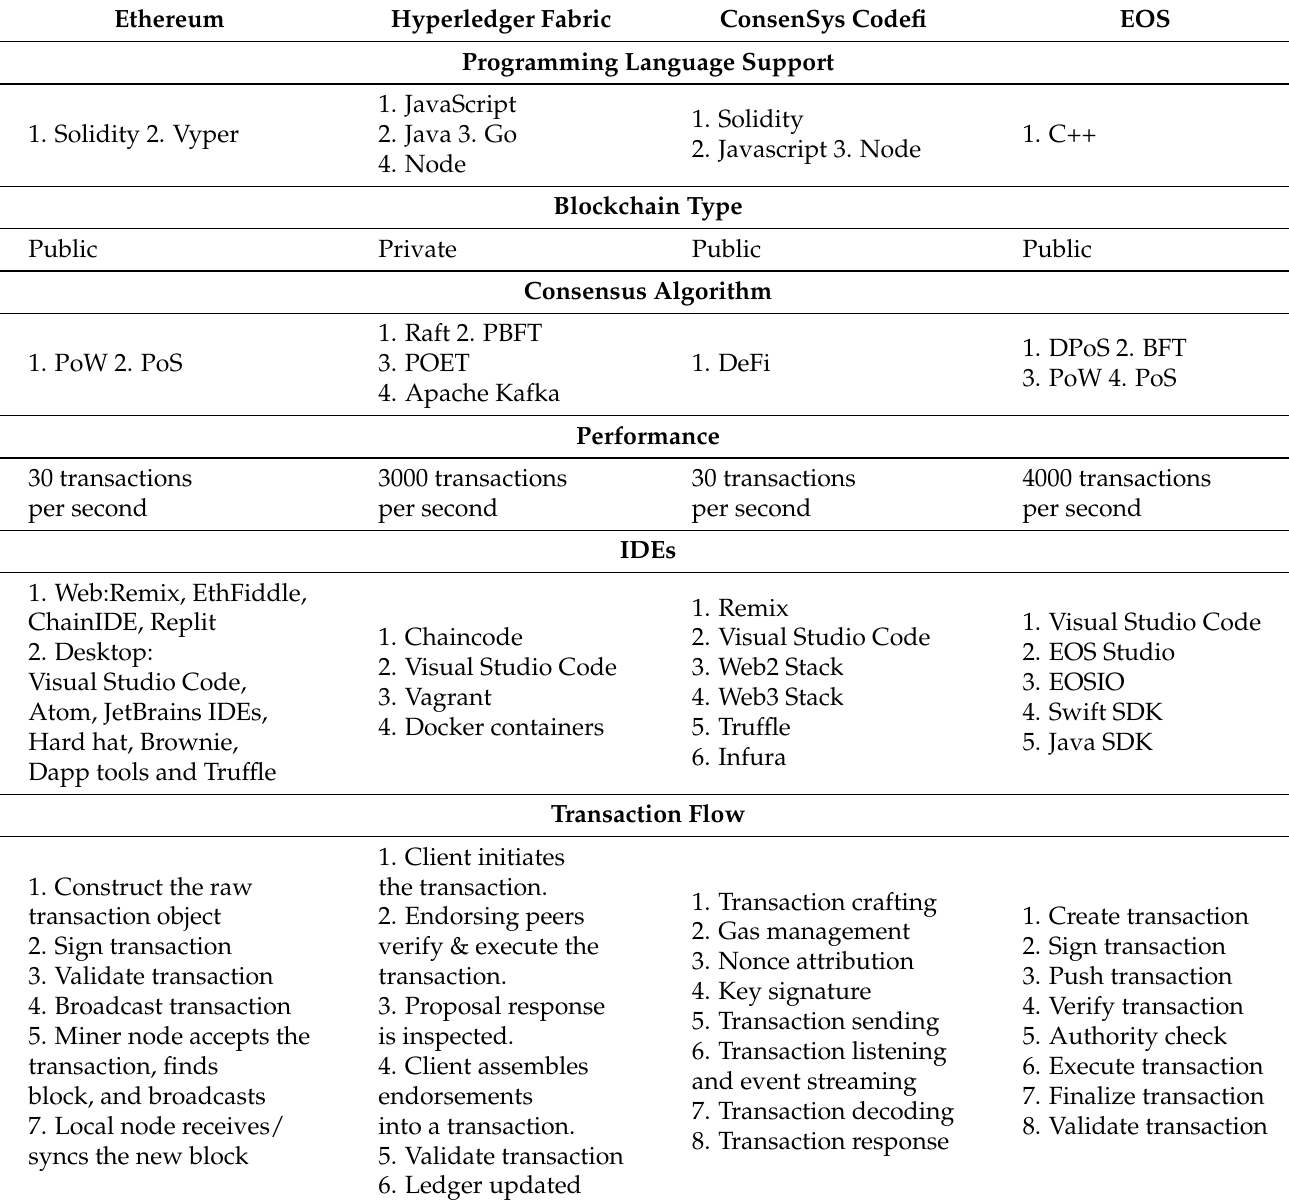
Table 3. A comparison of blockchain operating systems and their related